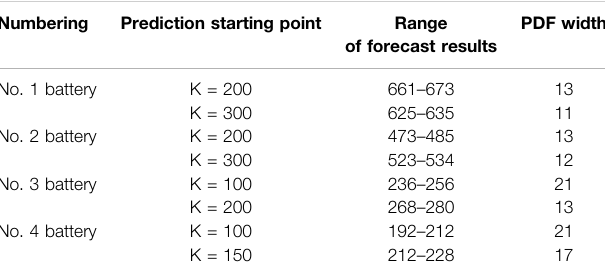
TABLE 3 | Probability density distribution of predicted results of nos. 1 – 4